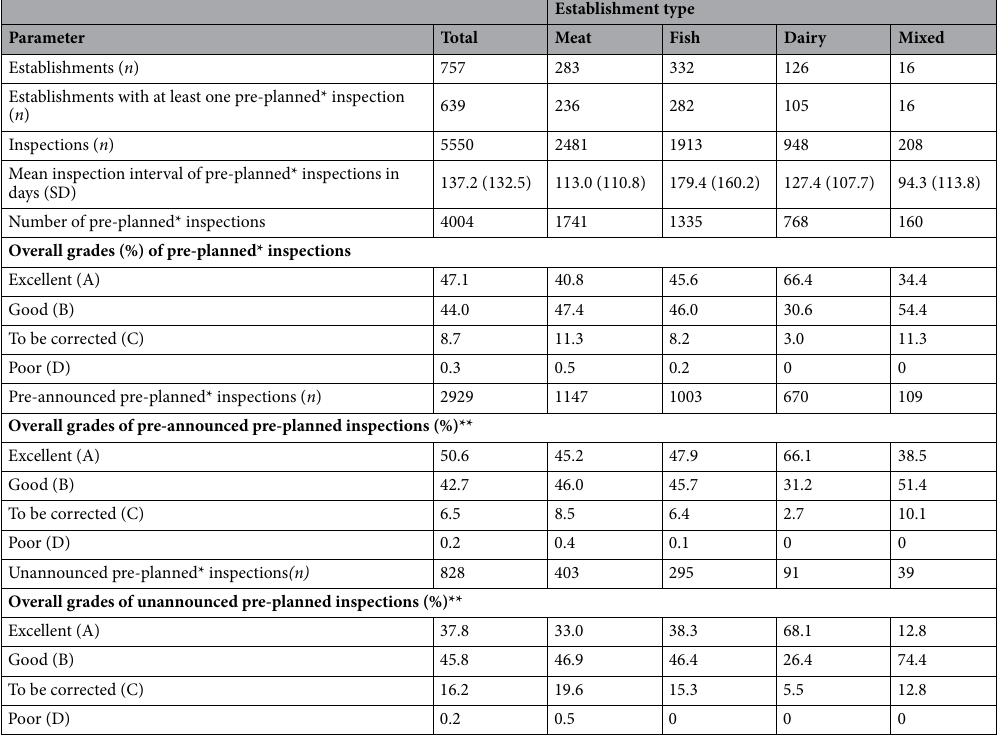
Table 1. Descriptive statistics of food control inspections of meat, fish, and dairy establishments in Finland 2016–2019. *Defined as (1) having overall grade A or B at the previous inspection, (2) marked as pre-planned inspection, and (3) having at least 14 days inspection interval. **247 inspections for which information about pre-announcement was